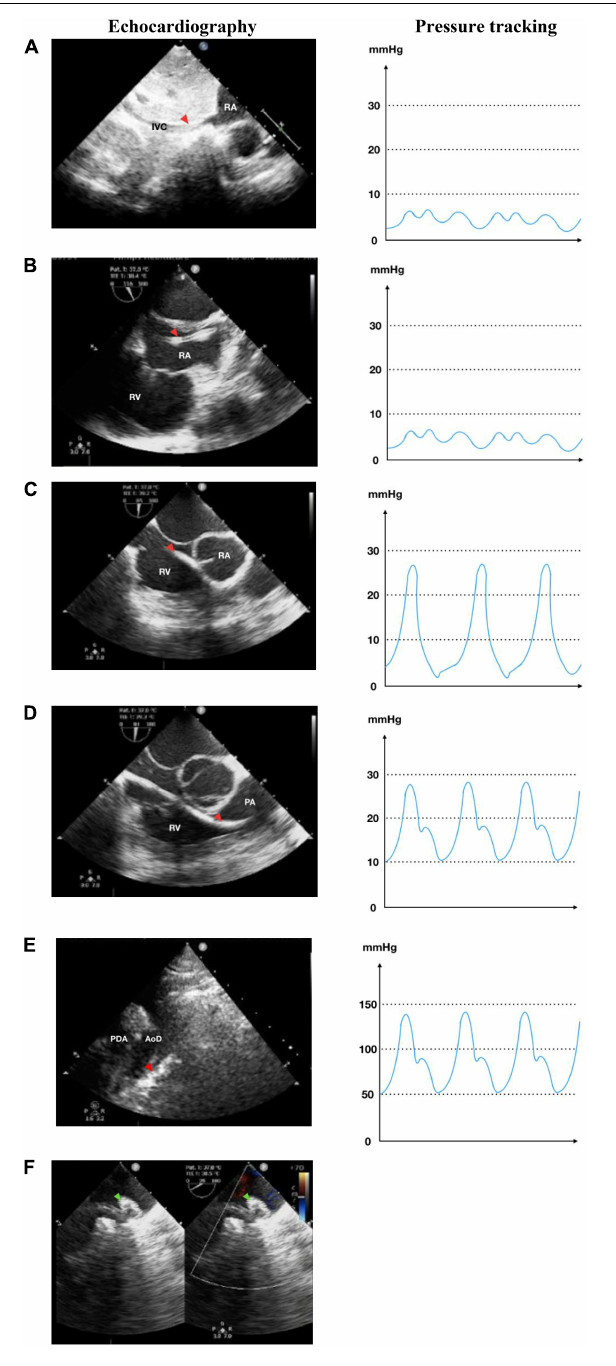
FIGURE 2 | Antegrade transvenous approach of percutaneous patent ductus arteriosus (PDA) closure. (A) Catheter is seen in IVC in transthoracic echocardiography (TTE) subxiphoid view. (B) Catheter is seen in RA in TEE bicaval view (90–110 ◦ ). (C) Catheter in RV TEE 90 ◦ view. (D) Catheter enters PA in TEE 90 ◦ view. (E) Catheter crossed from PA towards AoD through PDA in TTE arch view. (F) The device is stowed in place in TEE (40–50 ◦ ). IVC, inferior vena cava; RA, right atrium; RV, right ventricle; PA, pulmonary artery; Ao, aorta; LA, left atrium; LV, left ventricle; AoD, descending aorta; PDA, patent ductus arteriosus. Red arrowhead shows the catheter head. Green arrowhead indicates the occluder